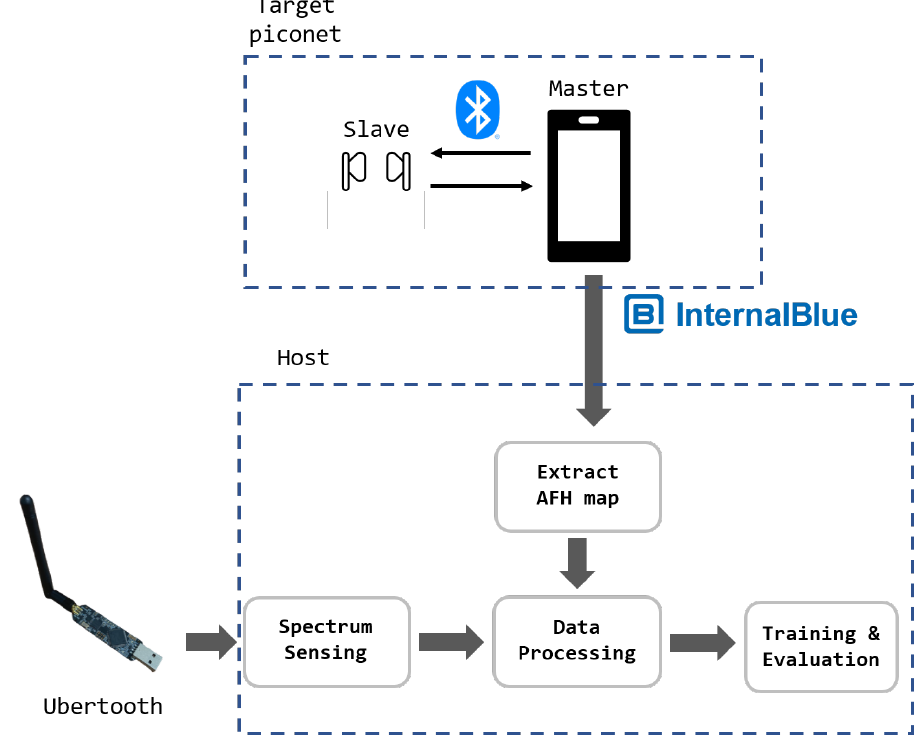
Figure 2. An overview of the experimental process in the AFH map collection and prediction